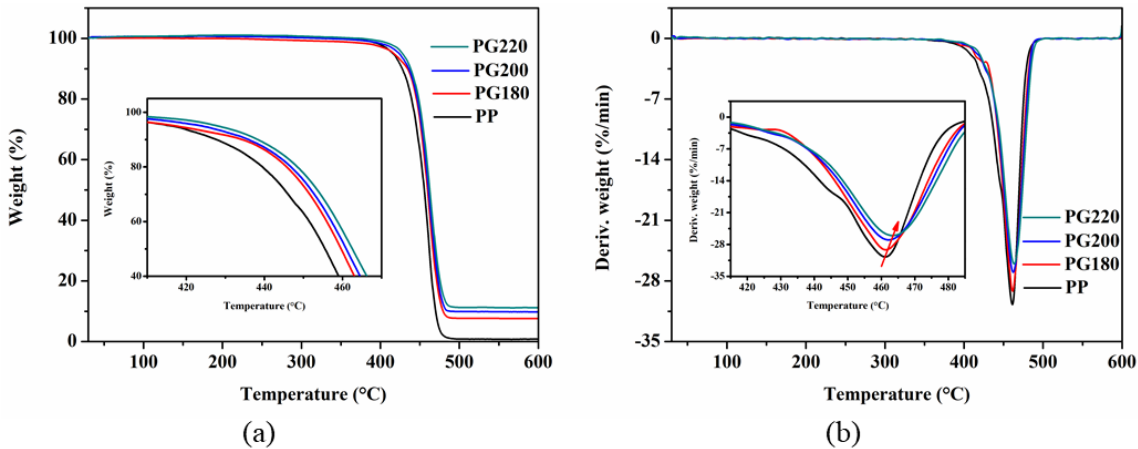
Figure 7. ( a ) TGA and ( b ) DTG thermograms for neat PP and PP/GIC composite samples.